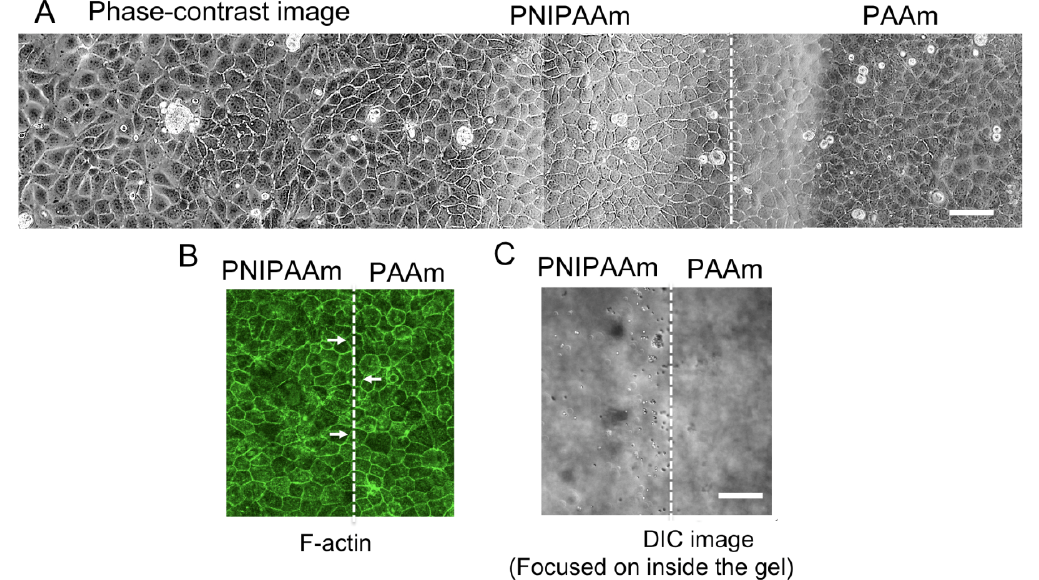
Figure 3. Representative pictures of Madin-Darby canine kidney (MDCK) cells on the border section of a combined gel after the temperature decreased. ( A ) Phase-contrast image of a large area, include PNIPAAm and PAAm gel side. Images were separately acquired at each location and converted to a single image; ( B ) MDCK cells stained with Alexa Fluor 488-conjugated phalloidin. No guidance effect between the two gels was observed, even in the cells in contact with both the gels (arrow); ( C ) Confirmation of the border of the two gels by focusing inside the gel by differential interference contrast (DIC). Microbeads were embedded only within the PNIPAAm side. White dashed line indicates the anchored section of the two gels. Scale bar: 50 μ